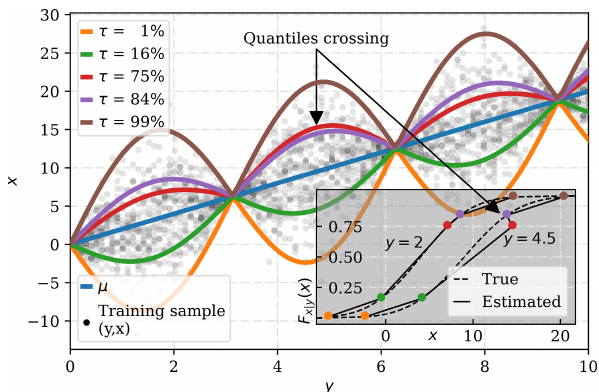
Figure 3. Simplified retrieval example of x from y . A model trained to minimize the MSE can only aspire to predict the expected value of x at a given y , indicated by the line µ , while a quantile regression can describe the aleatoric uncertainty estimating quantiles at level τ . These quantiles can then be used to estimate F x | y (x) and derive µ from it. However, quantile crossing can occur if the quantiles are not perfectly estimated.